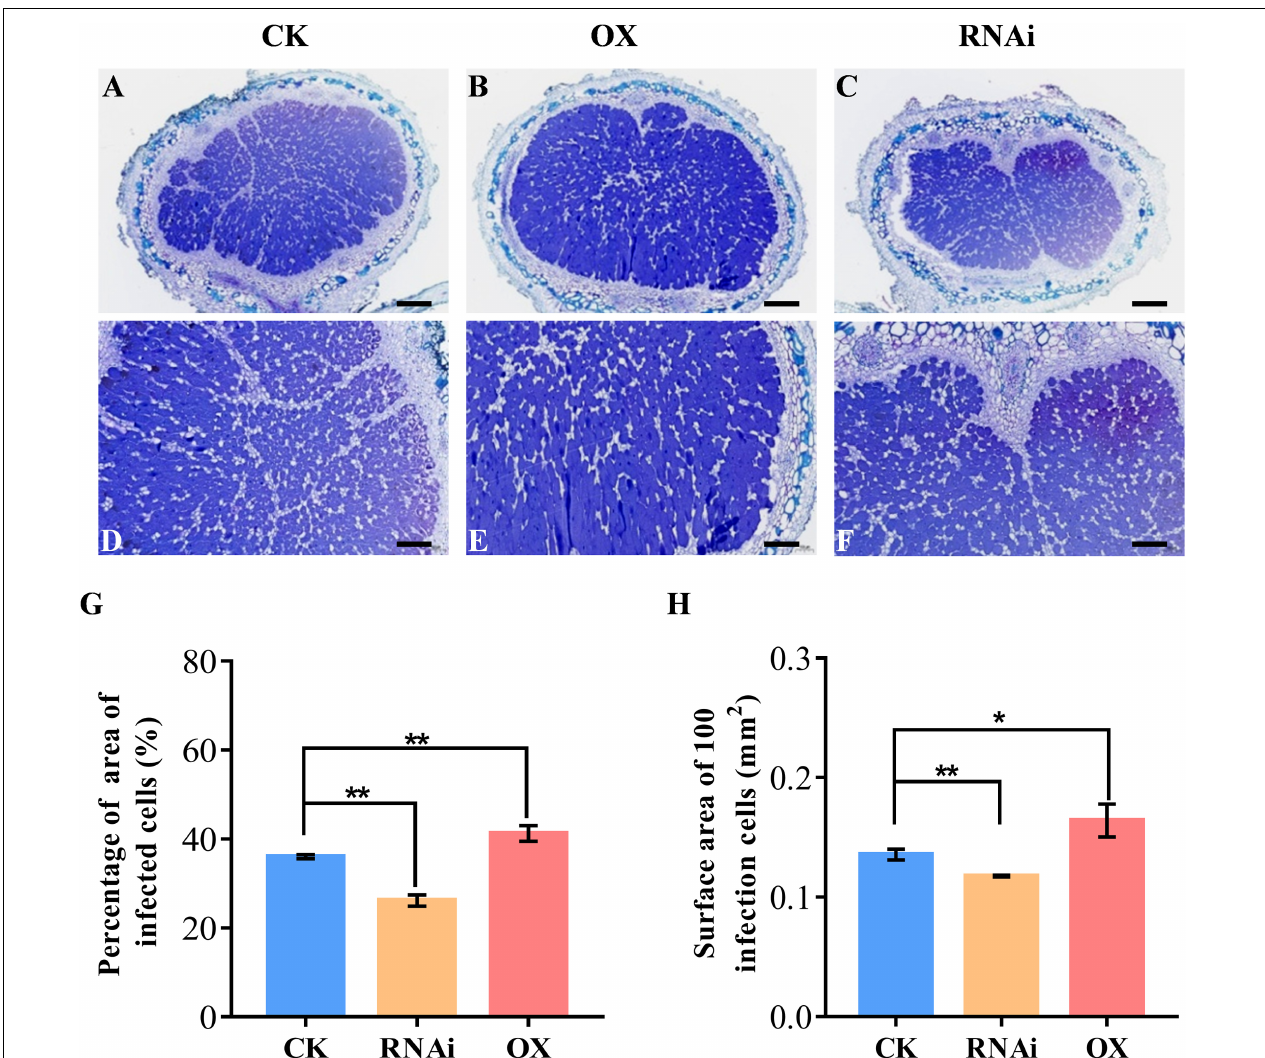
FIGURE 5 | Cross sections of toluidine blue-stained nodule of GmHSP17.1 OX and RNAi lines. (A,D) Toluidine blue staining of nodules expressing CK empty vector. (B,E) Toluidine blue staining of nodules overexpressing of GmHSP17.1 . (C,F) Toluidine blue staining of nodules of GmHSP17.1 RNAi lines. (G) Percentage of area of infection cells to all cells in one nodule section. (H) Surface area of 100 infection cells. (A–C) Scale bar = 200 µ m, (D–F) scale bar = 100 µ m. Asterisks indicate statistically significant differences according to Student’s t -test (two-tailed) (* p < 0.05; ** p < 0.01), these experiments were repeated at least three times and similar results were obtained; n =